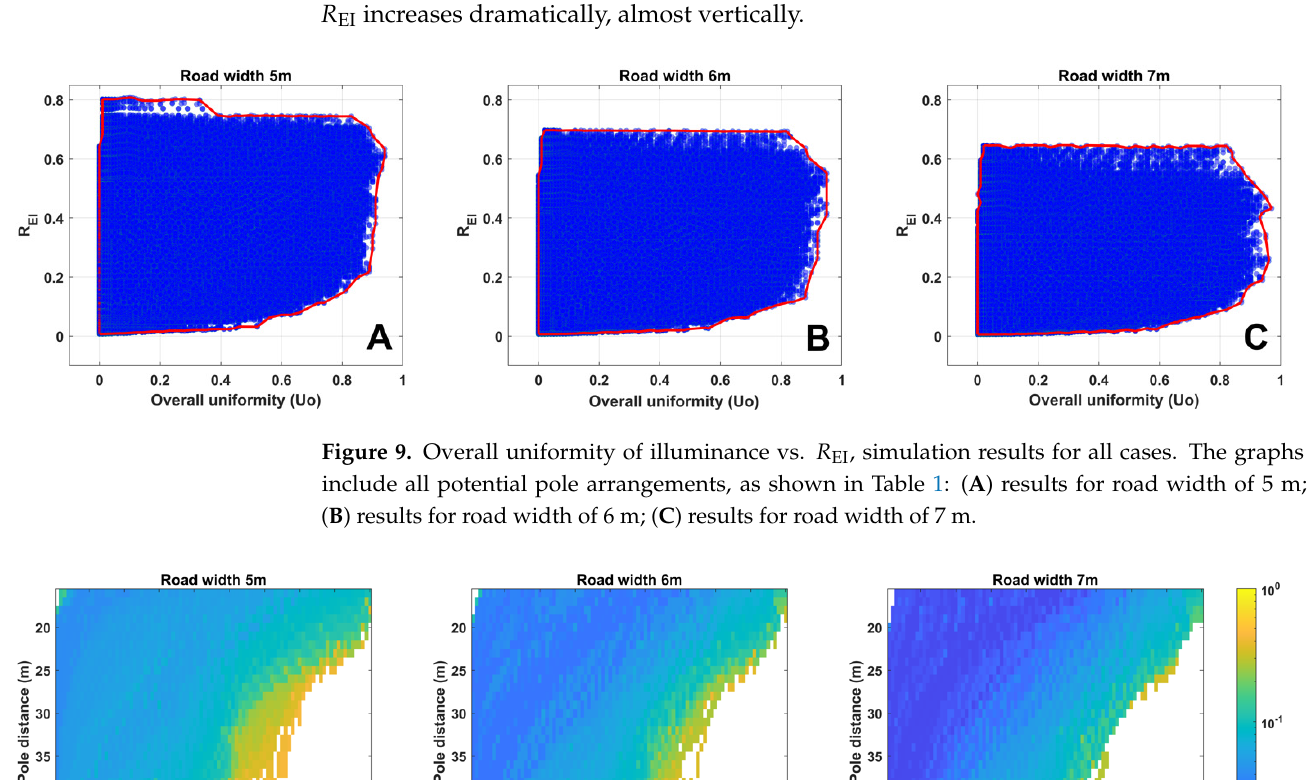
R EI increases dramatically, almost vertically.